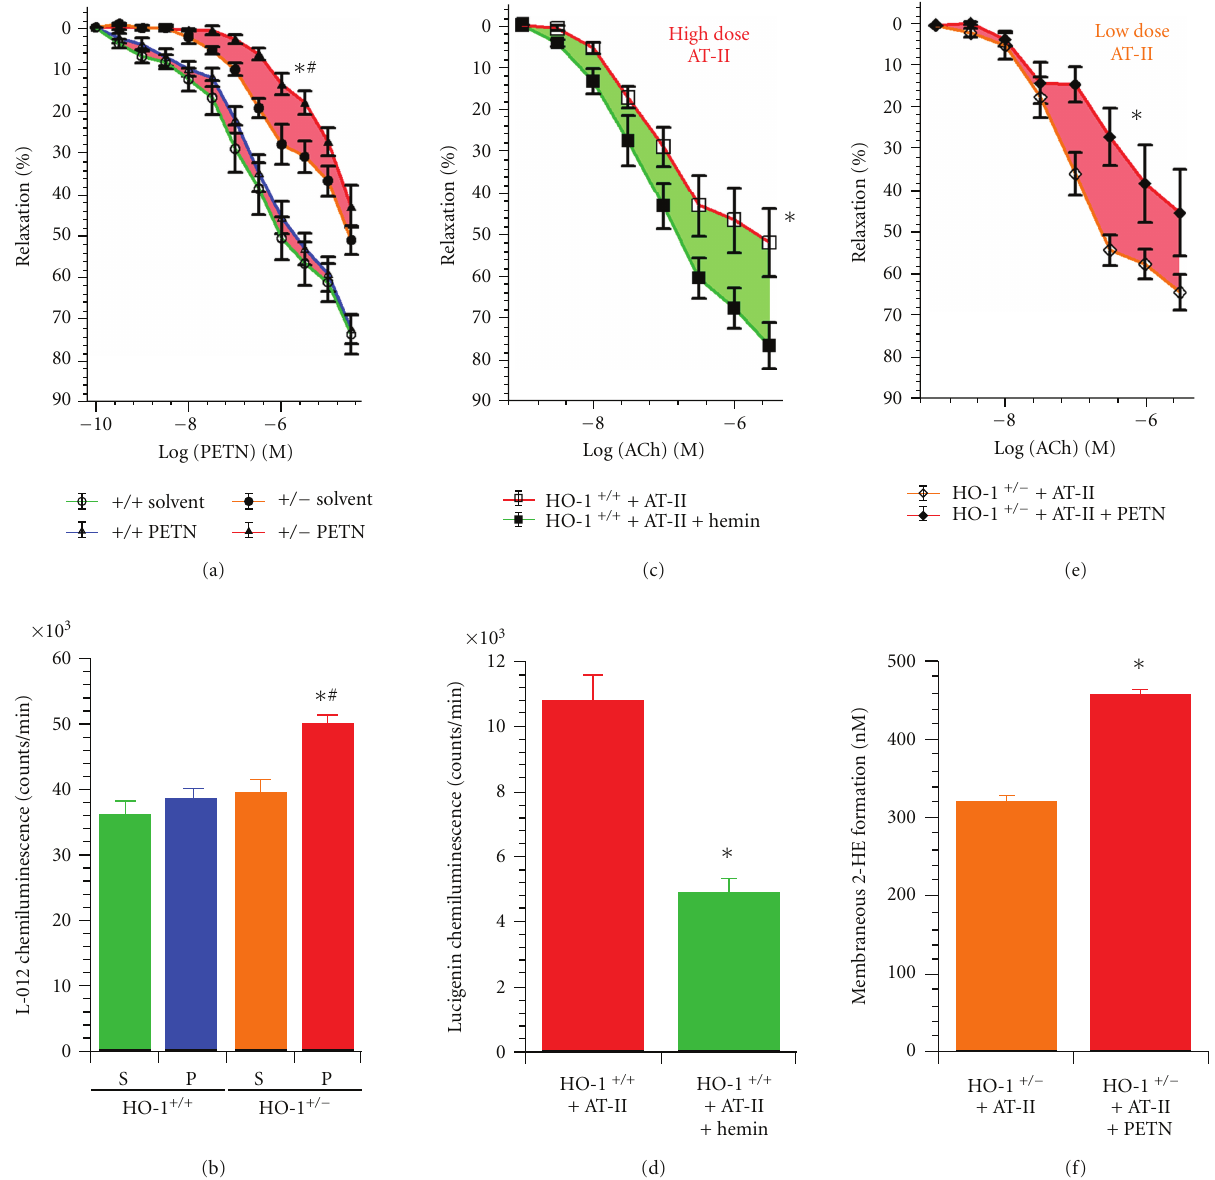
Figure 2: E ff ects of HO-1 deficiency versus HO-1 induction on vascular improvement by pentaerithrityl tetranitrate (PETN). (a, b) PETN treatment (75mg/kg/d for 4d) had no e ff ect on PETN potency (PETN-induced relaxation) in aorta from control mice (HO-1 + / + ) but caused nitrate tolerance (see area between curves) in aorta from mice with partial HO-1 deficiency (HO-1 + / − ). In accordance, cardiac mitochondrial ROS formation (L-012 ECL) was increased in PETN-treated HO-1 + / − mice. P < 0 . 05: ∗ versus HO-1 + / + /DMSO; # versus HO-1 + / − /DMSO. S: solvent; P: PETN-treated. (c, d) Hemin (25mg/kg i.p.)-triggered HO-1 induction improved high-dose AT-II (1mg/kg/d for 7d)-induced endothelial dysfunction (ACh-response) in aorta (see area between curves) and NADPH oxidase activity in heart (lucigenin ECL) from control mice (HO-1 + / + ). P < 0 . 05: ∗ versus AT-II-treated HO-1 + / + /DMSO. (e, f) PETN (75mg/kg/d for 7d) failed to prevent endothelial dysfunction (ACh-response) induced by low-dose AT-II (0.1mg/kg/d for 7d) in aorta from HO-1 + / − mice (see area between curves). In accordance, PETN did not improve NADPH oxidase activity (2-HE formation by HPLC analysis) in cardiac samples from AT-II-treated HO- 1 + / − mice. P < 0 . 05: ∗ versus AT-II-treated HO-1 + / − /DMSO. All data are mean ± SEM of aortic rings and hearts from 4-5 animals/group. Modified from